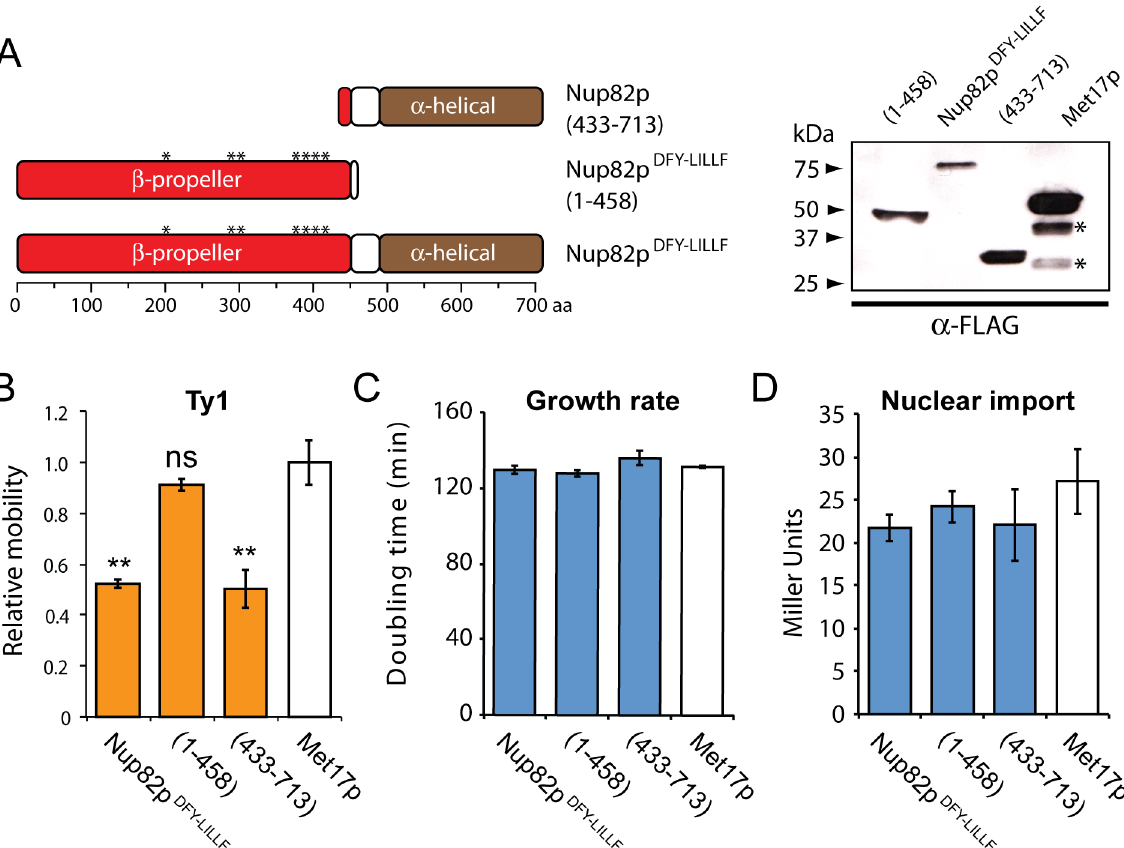
Fig 6. The expression of dominant negative NUP82 and its impact on Ty1 mobility. (A) Left . A linear domain diagram of Nup82p DFY-LILLF and derived deletion mutants [Nup82p(433–713) and Nup82p DFY-LILLF (1–458)]. Asterisks mark the mutations that decouple Nup82p from the nuclear pore complex. Right . Western blot analysis to detect the expression of FLAG-tagged Nup82p DFY-LILLF and its derivatives, compared to the expression of a control protein (Met17p) in the wild-type background ( (cid:3) Met17p degradation products). The effect of Nup82p DFY-LILLF expression on (B) Ty1 mobility, (C) doubling time in a liquid medium and (D) the nuclear import of the reporter protein LexA-MBP-Gal4 (AD), relative to the expression of MET17 (error bars: standard error, n > 3; (cid:3)(cid:3) Tukey–Kramer method, p < 0.05).